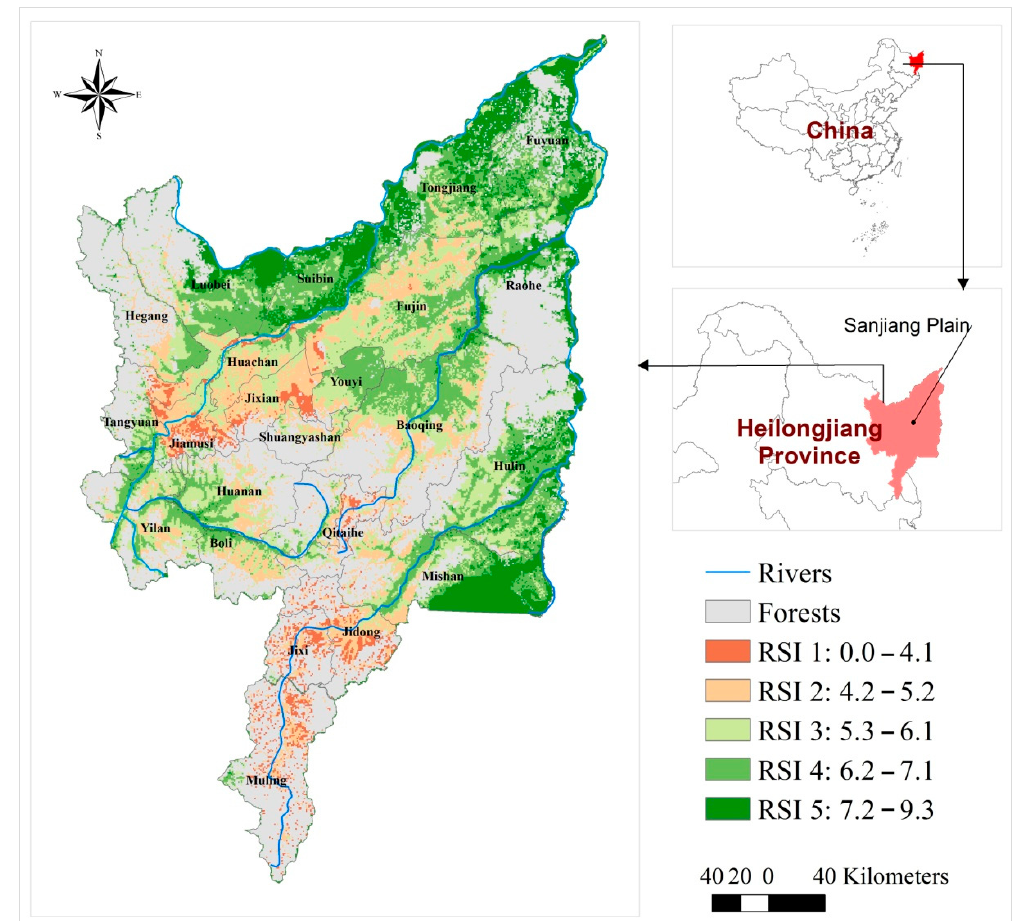
Figure 1. Spatial pattern of wetland restoration suitability.